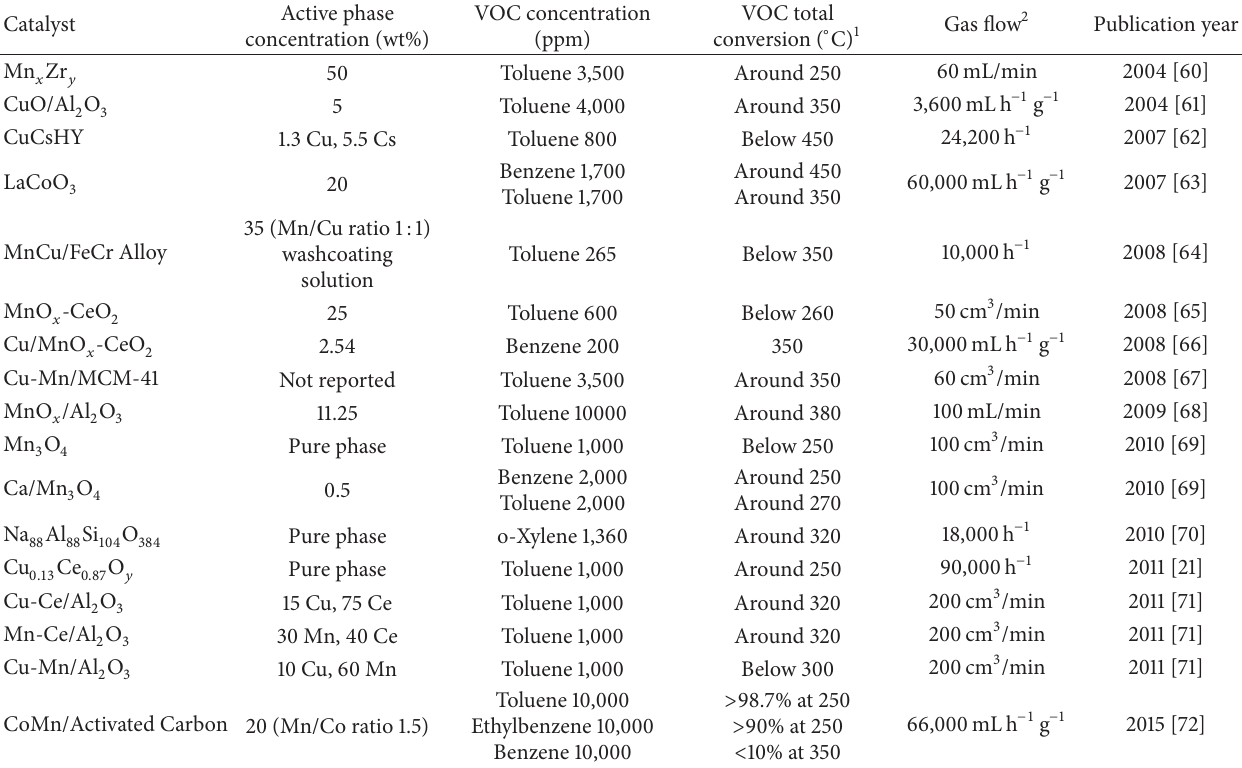
Table 2: Non-noble metal based catalysts in the recent